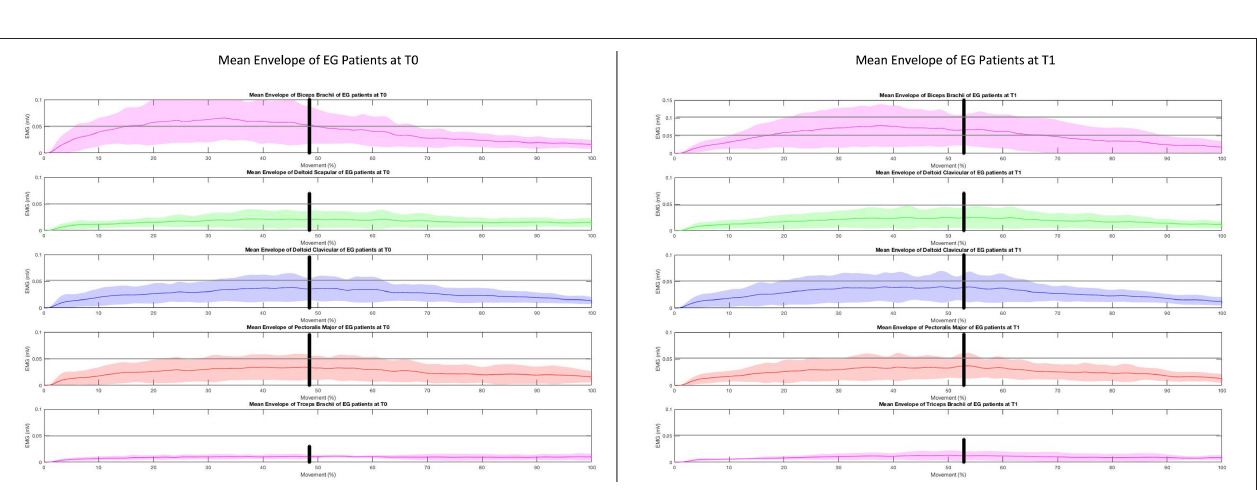
FIGURE 4 | EMGs muscle activity during the “hand-to-mouth” task in stroke patients before and after the upper limb Robot-assisted